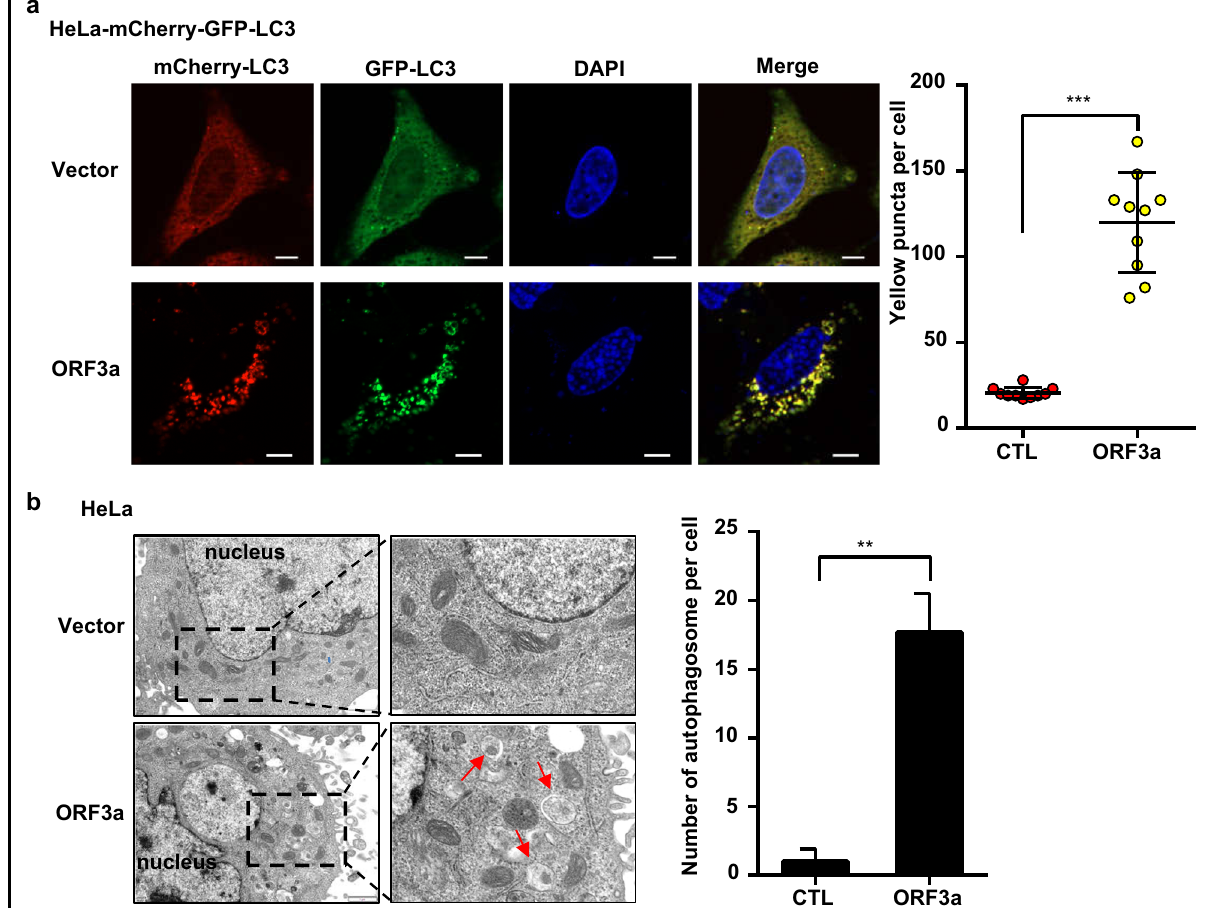
Fig. 3 ORF3a blocked autophagosome – lysosome fusion. a ORF3a blocked autophagosome – lysosome fusion, as shown by autophagy fl ux assays. HeLa cells with stable expression of mCherry-GFP-LC3 were observed by fl uorescence confocal microscopy after expression of ORF3a. Scale bars, 0.25 μ m. b ORF3a caused the accumulation of formed autophagosomes in HeLa cells. Control cells and ORF3a-expressing cells were analyzed by transmission electron microscopy. Arrows indicate the accumulated formed double-layered autophagosomes in cells. Scale bars, 10 μ